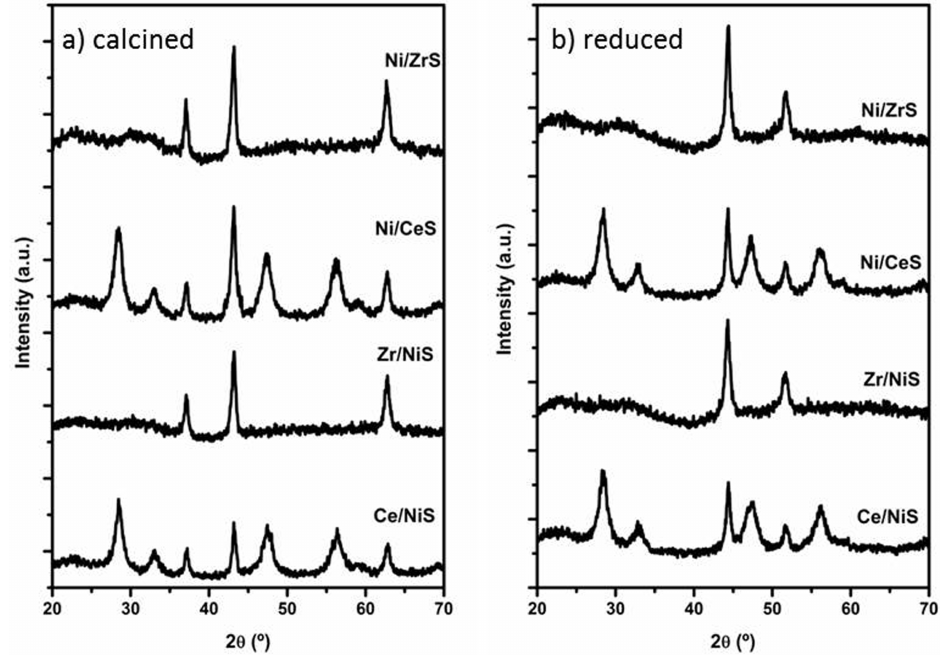
Figure 4. XRD patterns of the Ce- and Zr-modified Ni/SiO ( b )